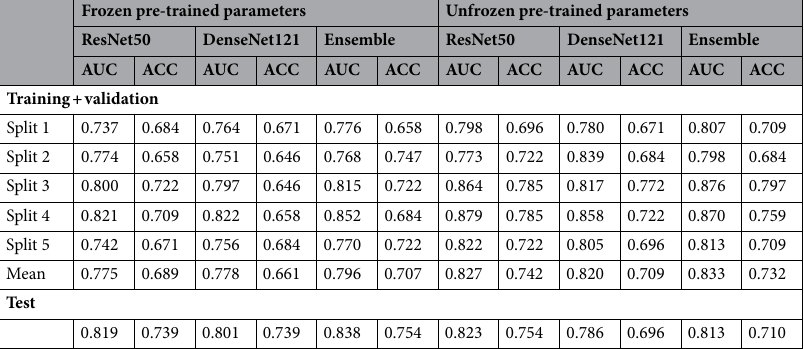
Highlighted imaging regions according to Grad‑CAM. The decision process to classify liver cirrhosis as being alcohol related or non-alcohol related was further visualized using Grad-CAM analysis for ResNet50 trained with unfrozen pre-trained parameters. According to Grad-CAM analysis, the right liver lobe (alcoholic liver cirrhosis 42%, 14/33; other-than-alcoholic liver cirrhosis 61%, 22/36) and the portal area (alcoholic liver cirrhosis 30%, 10/33; other-than-alcoholic liver cirrhosis 19%, 7/36) were the imaging regions that were most frequently decisive for the classification process in both groups. Thereby, no significant differences regarding distribution of decisive imaging regions between the two patient groups were observed (Table 3). Exemplary images of the Grad-CAM analysis are provided in Fig. 3.